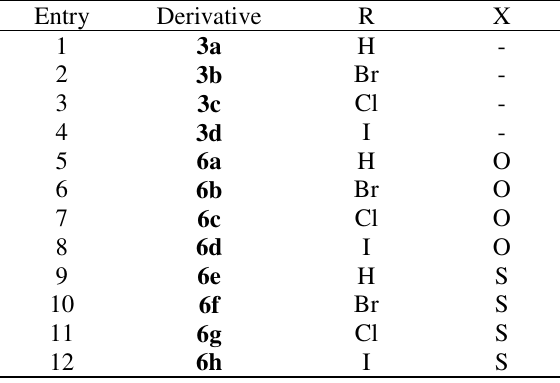
Table 1. Derivatives of synthesized